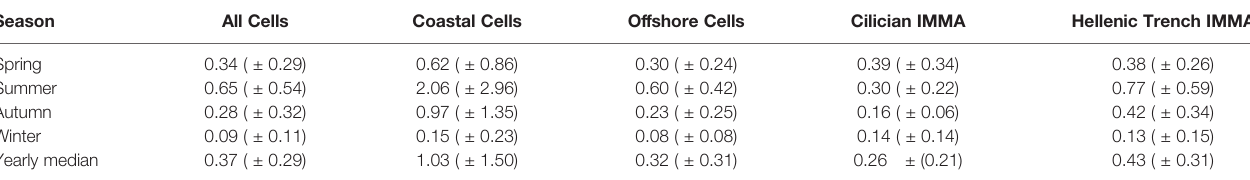
TABLE 3 | Summary of seasonal differences in vessel density for different regions within the survey